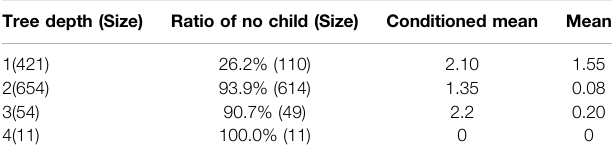
TABLE 2 | The reproduction number in each generation of transmission in the spreading tree. Tree depth (Size) Ratio of no child (Size)